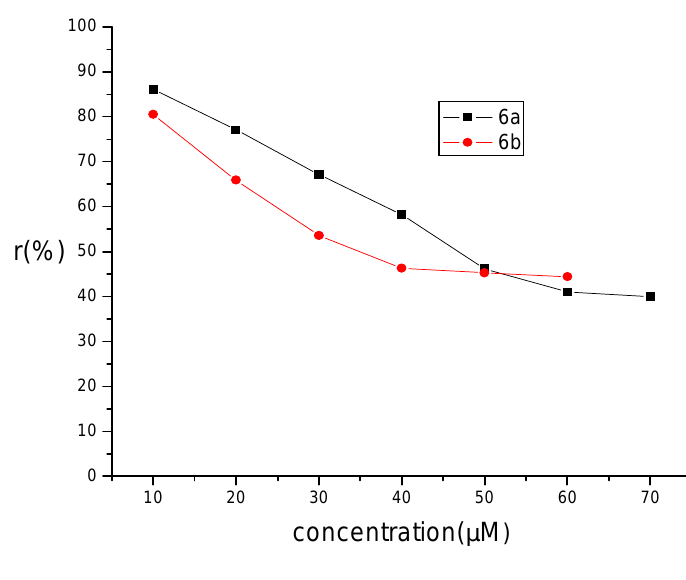
Figure 6. Fluorescence quenching curve of ligands at different